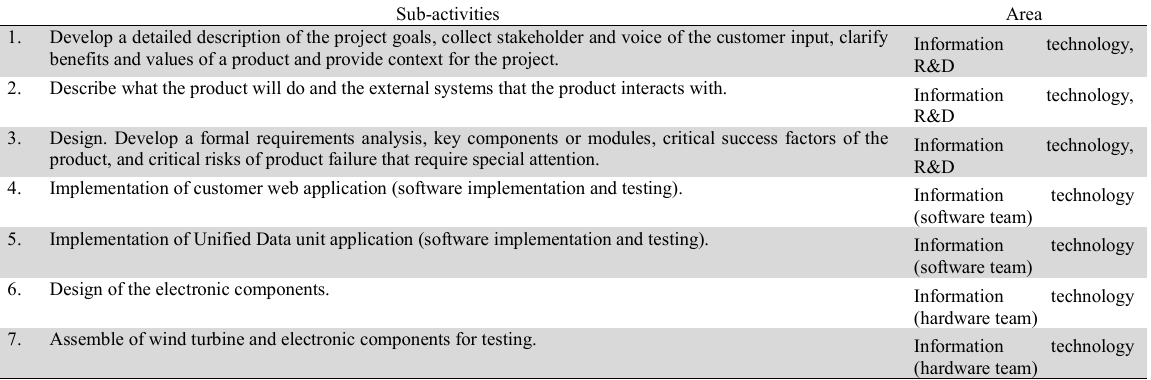
Description of the main activity “New smart and connected products development”